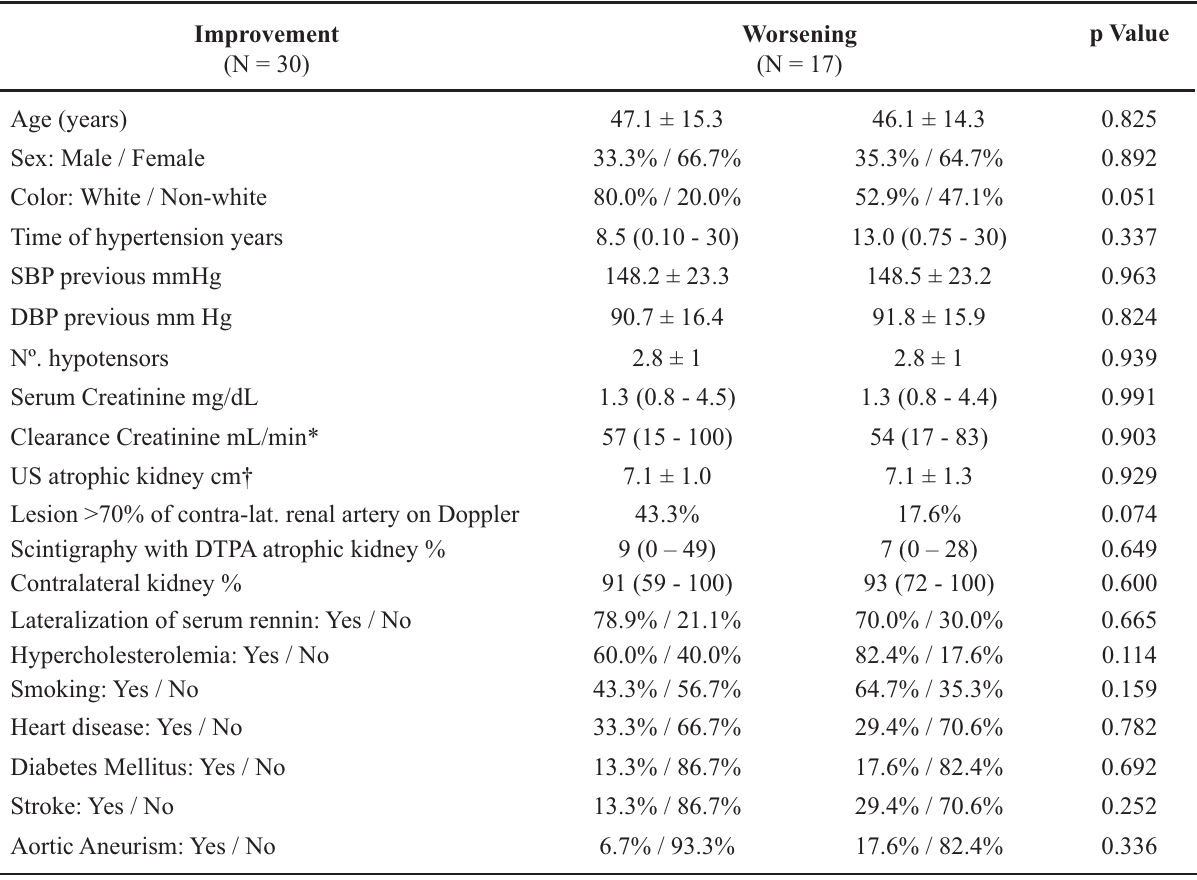
Table 6 – Characteristics of the patients in accordance with the response of their renal function to nephrectomy.